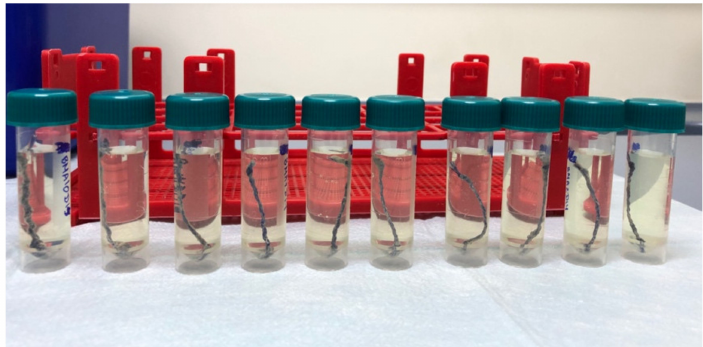
Figure 1. Ureteral stents fragments dipping in artificial urine (Day